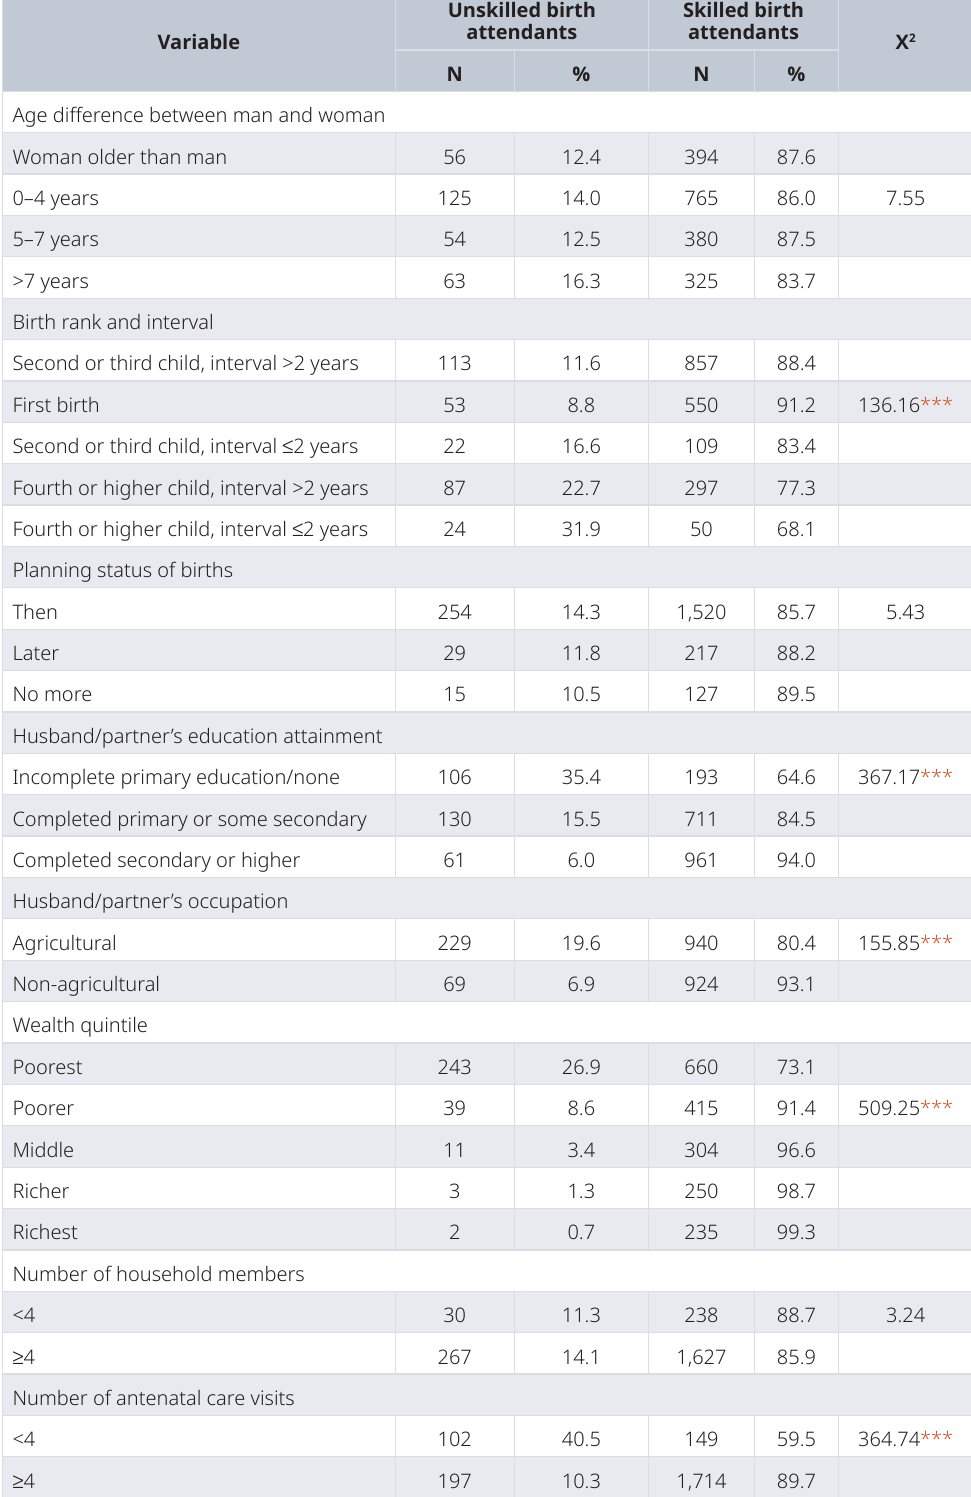
Table 3. Bivariate analysis of women’s characteristics and type of assistance at